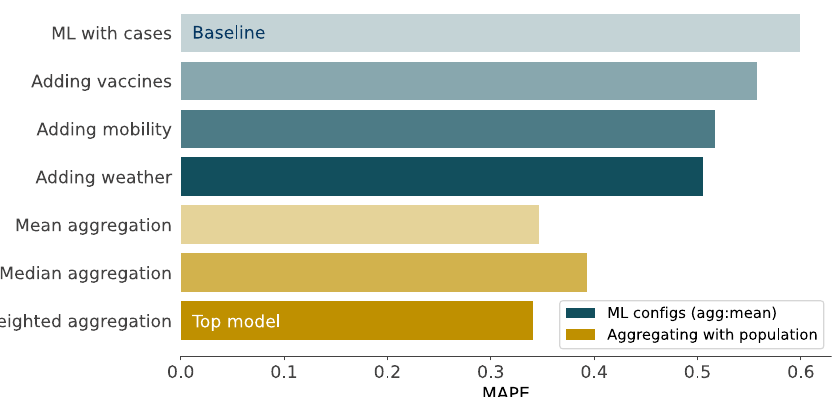
Figure 11. Cumulative improvements for the Spain case in the test split. We color separately (1) improvements made on ML models by adding more inputs (aggregating always with mean), (2) improvements made when aggregating the ML models (with full inputs) with population models with different aggregation methods.